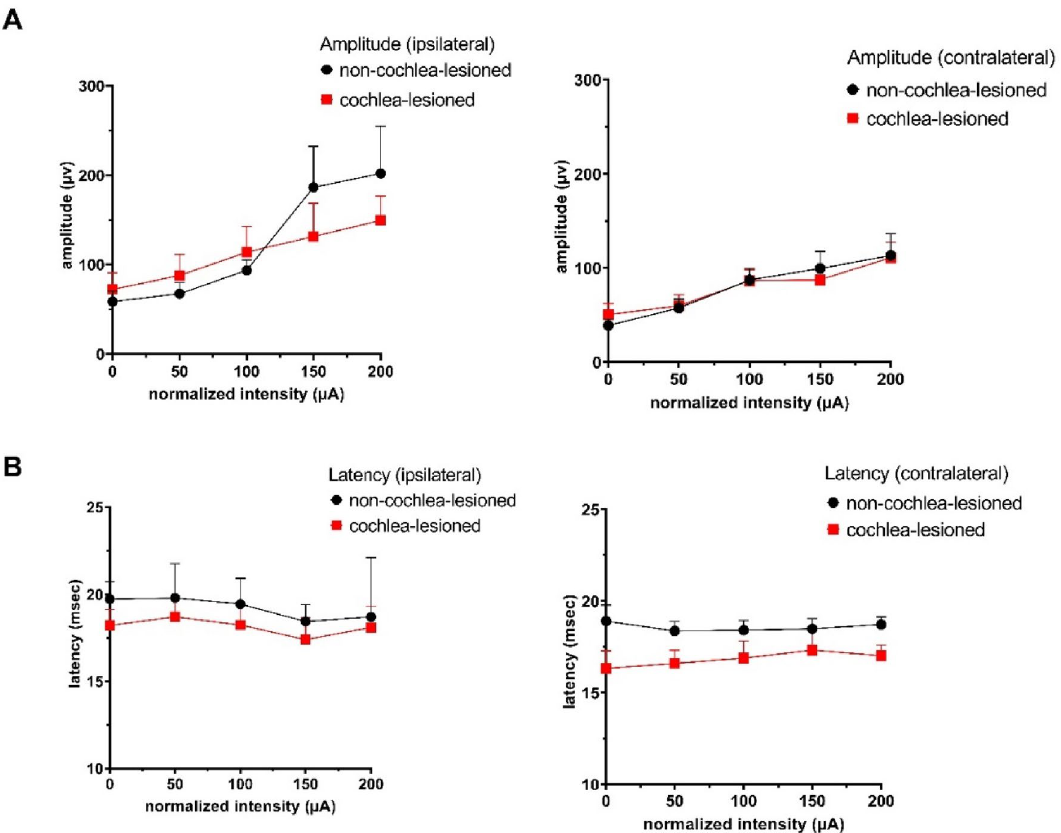
in the ipsilateral and contralateral tail of striatum in non-cochlea-lesioned and cochlea-lesioned rats evoked by stimulation of the round window. Symbols represent means and bars 1